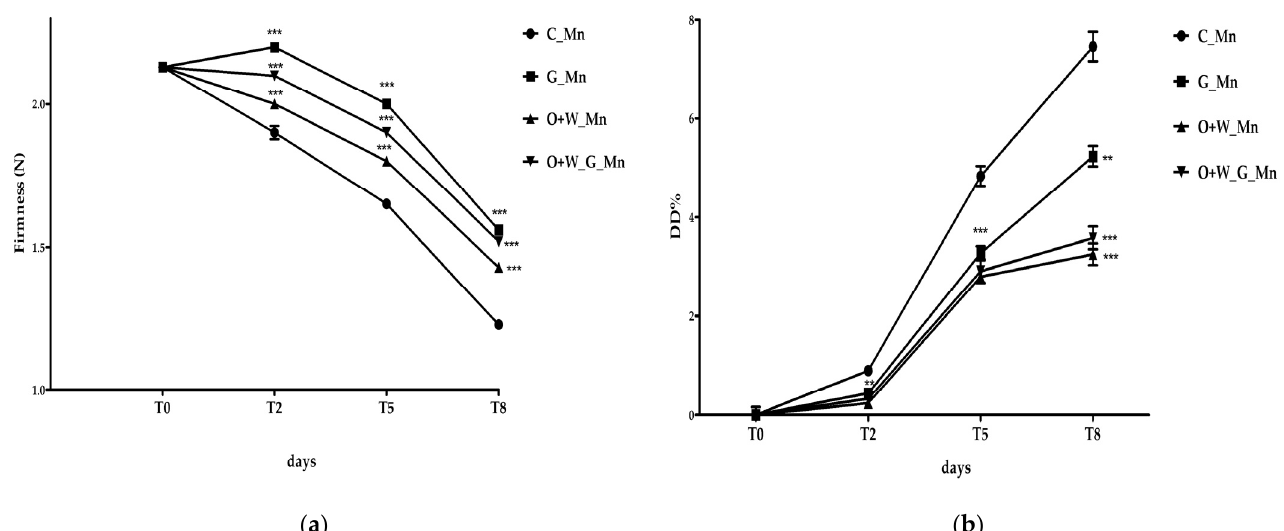
Figure 3. The firmness (N) ( a ) and deterioration degree (%) ( b ) of mulberry fruits treated with edible coatings over 8 days at cold storage. All values are expressed as the means ± SD (n = 3). The statistical significance (** p < 0.01; *** p < 0.001) was determined compared with the control group at the corresponding times .